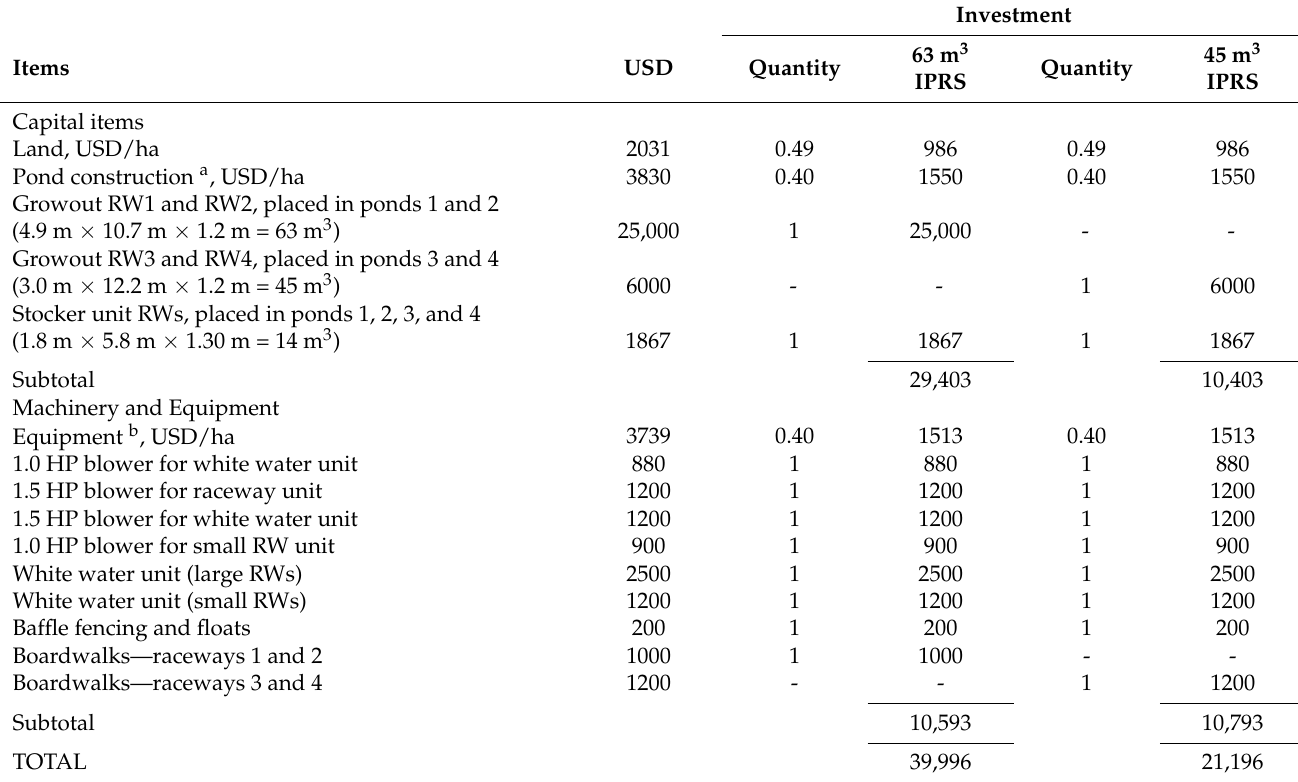
Table 2. Land, construction of 0.4 ha ponds and in-pond raceway system (IPRS) capital items, and machinery and equipment investment for raising stocker and foodsize hybrid catfish (Channel catfish × Blue catfish, I. furcatus Ictalurus punctatus ) in the same pond, ♀ ♂